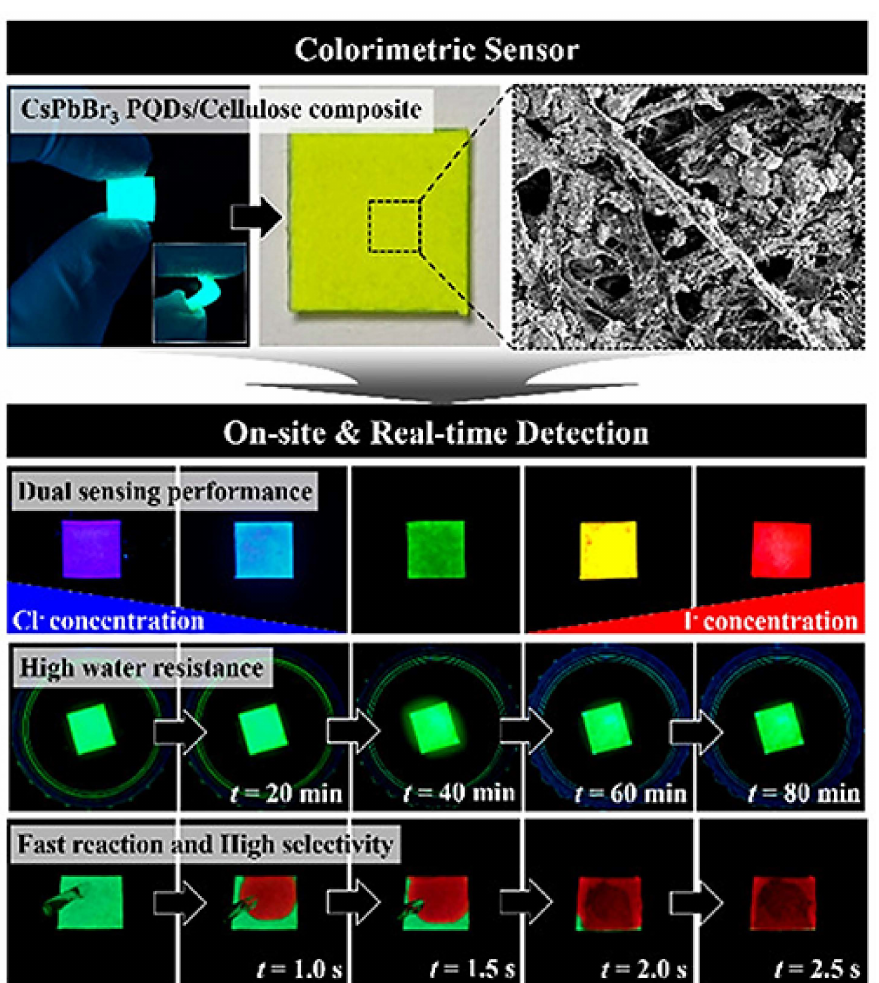
Figure 6. Cellulose-based colorimetric sensor coupled with CsPbBr 3 PQDs. Real-time detection of Cl − ions and I − ions by naked eye. Reproduced with permission from ref. [109] © 2023 American Chemical